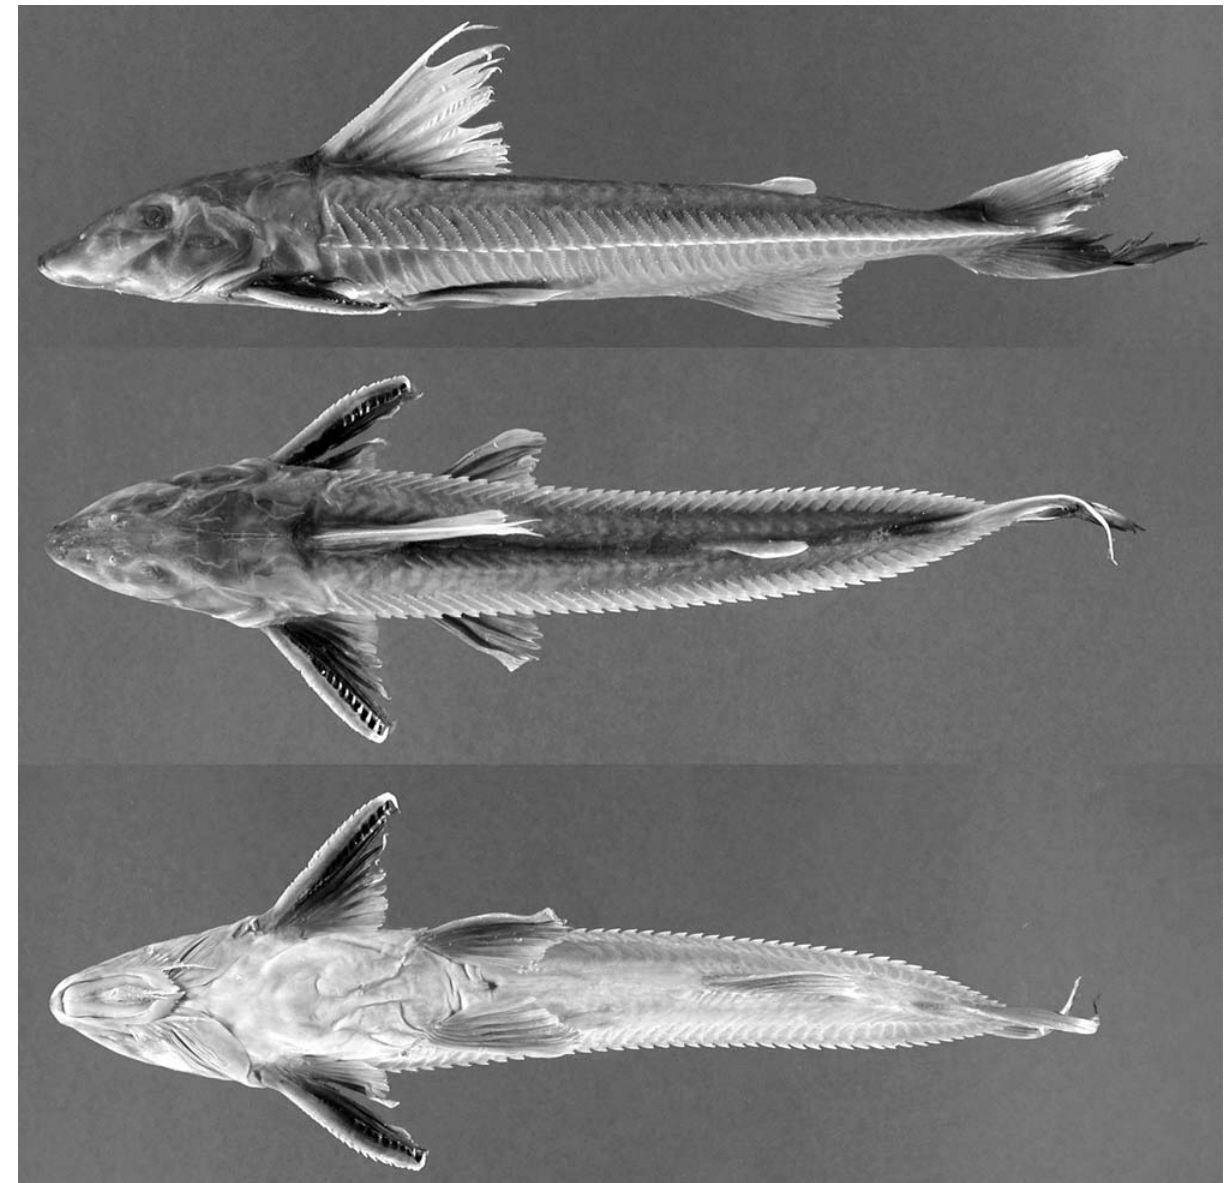
Fig. 23. Leptodoras cf. cataniai Amazon form, ANSP 180925 (SL 194 mm), rio Iça (Amazonas dr.), 1.5 km downstream from Betania, Amazonas,